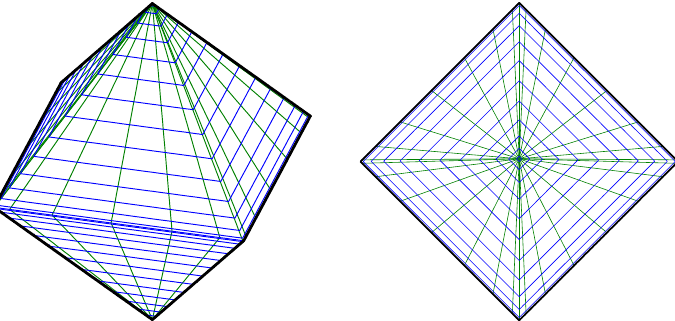
Figure 2. Unit sphere with identity matrix A ; exponents equal to 1; side and top view.